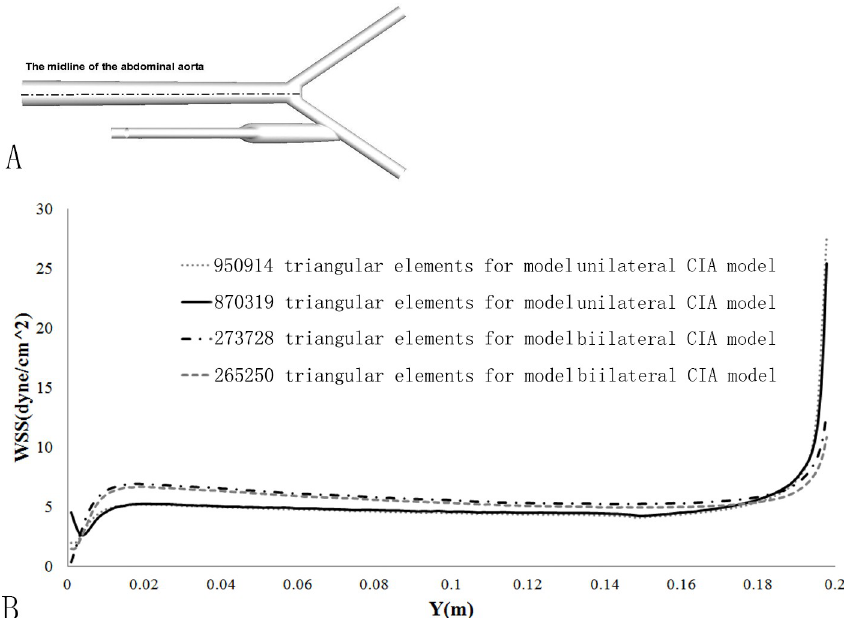
Fig 4. 3D Grid independence test. The WSS distributions along the aorta centerline were presented at two different meshes.